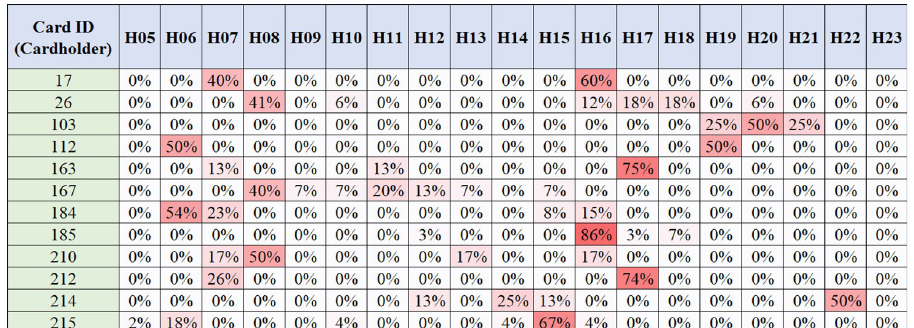
Fig 2. Travel profile (sample). Note: The columns represent the time bins; for example, H08 is the ratio of the number of trips per hour from 8:00 a.m. to 9:00 a.m. to the total number of trips of a passenger. The rows contain the data for each passenger, and the number of rows in the travel profile table matches the number of passengers included in the dataset.